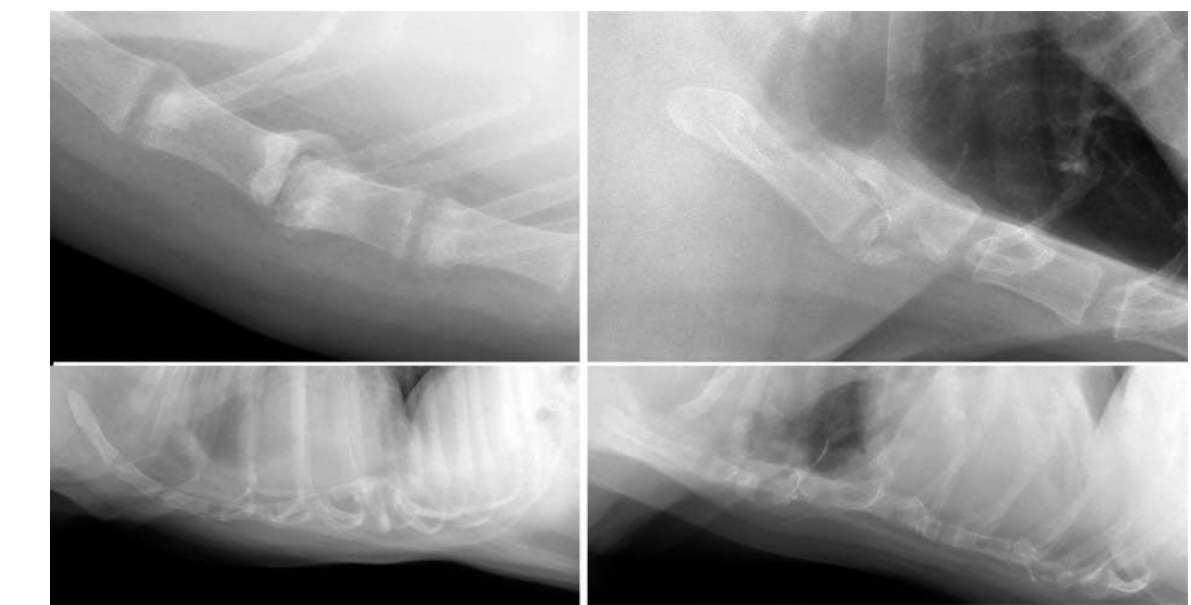
Figure 2. ( Top left ) panel: Degeneration of the intersternebral joint space in an 11-year-old, neutered female Welsh Springer Spaniel. The intersternebral cartilage space between the 4th and 5th sternebrae is narrowed, shows vacuum phenomenon, and is surrounded by new bone formation. The 5th sternebra is mildly displaced ventrally relative to the fourth sternebra. ( Bottom left ): Pectus excavatum in a 12-year-old male Pug. Dorsal deviation was noted in the caudal part of the sternum with border effacement of the ventral thoracic diaphragmatic surface and the caudal ventral cardiac silhouee and an altered position of the heart. ( Top right ): Luxation of the second sternebra in a 10-year-old male neutered mixed-breed dog. The second sternebra is displaced in craniodorsal direction and is overriding the manubrium of the sternum. ( Boom right ): Pathologic fractures of multiple sternebrae in 10-year-old male Chihuahua with malignant lymphoma.